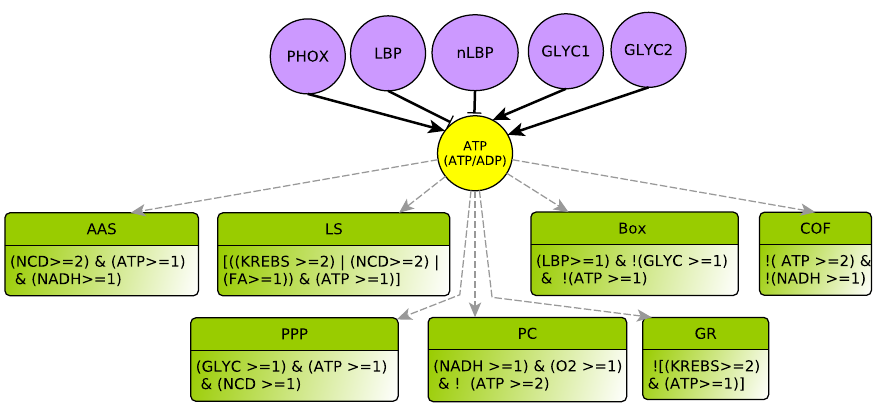
Figure 12. resources and target for ATP